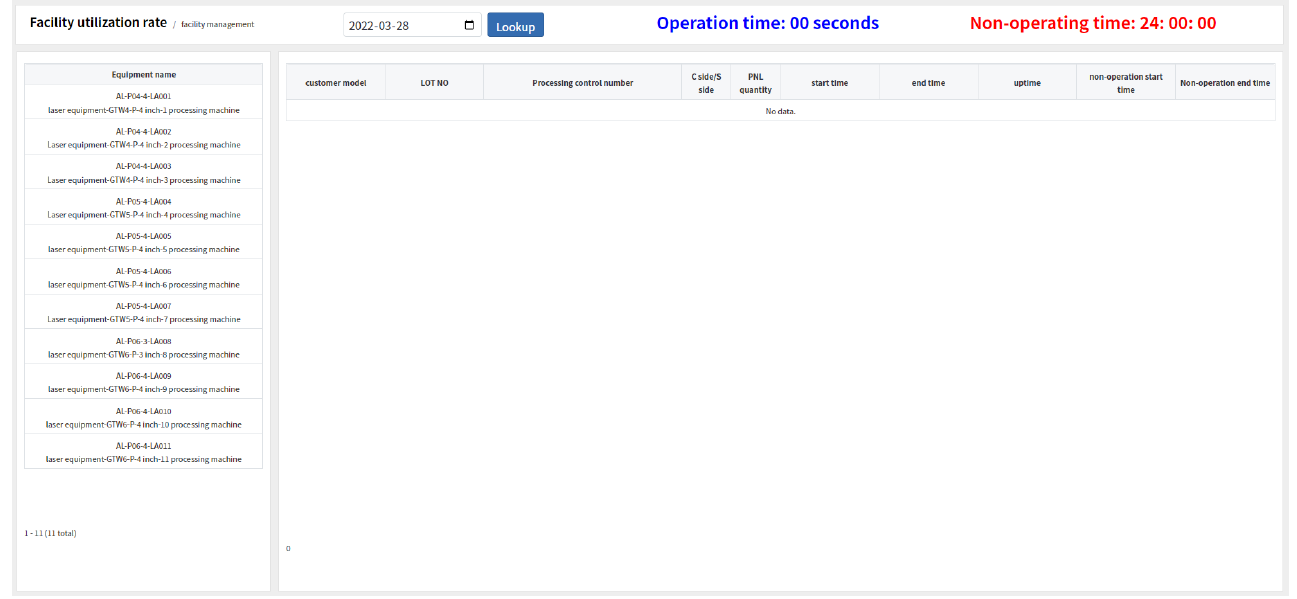
Figure 14. The status of the facility operation.